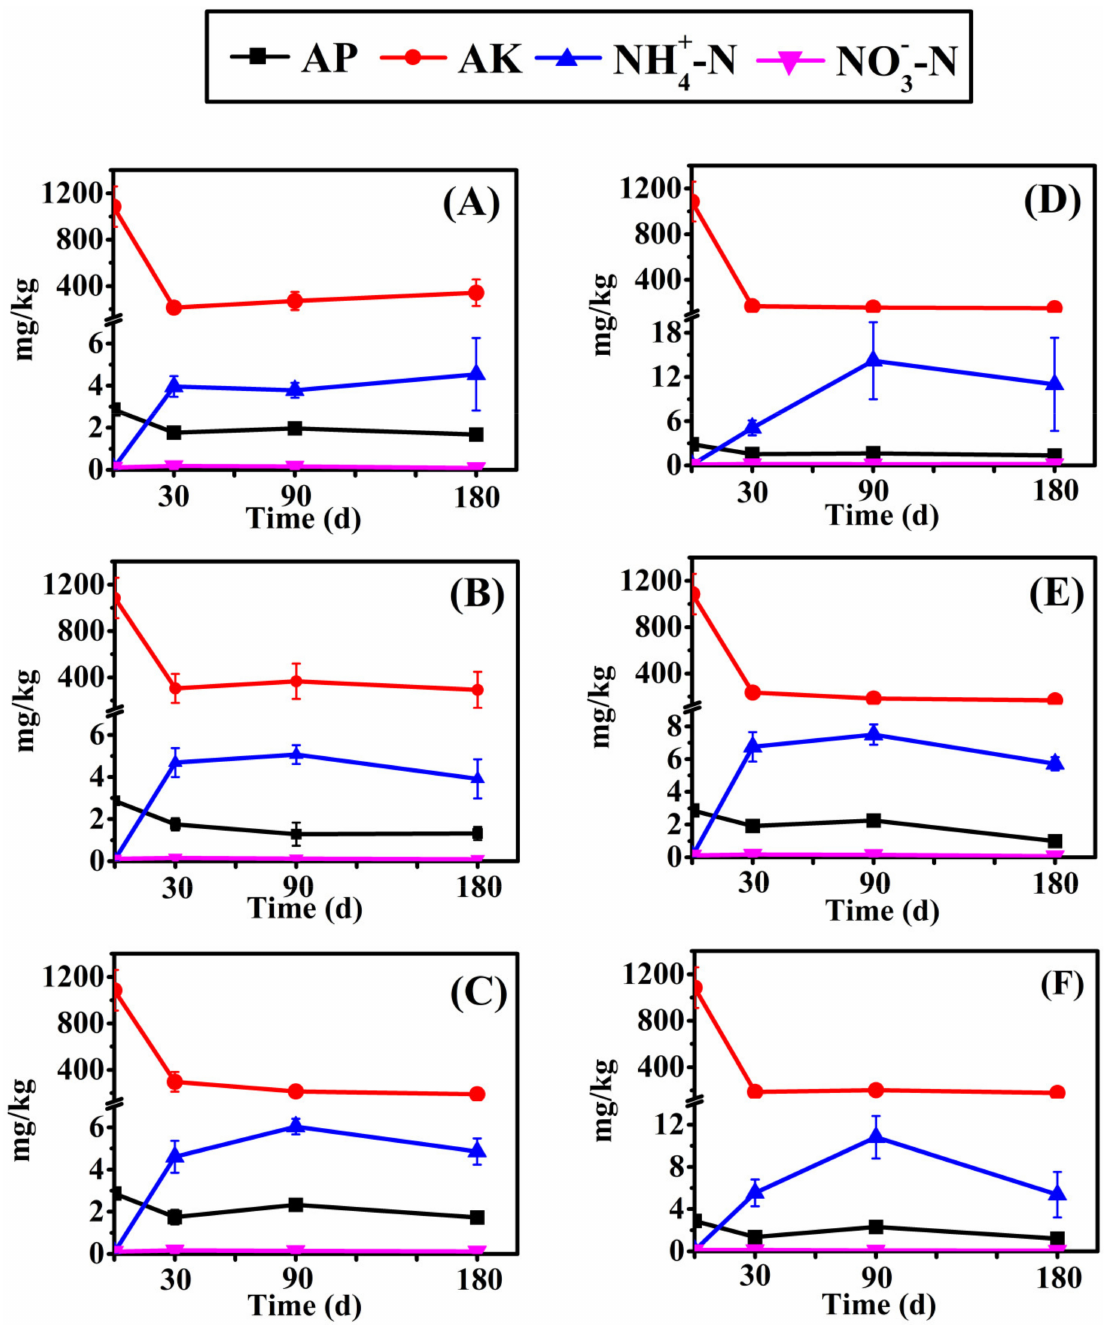
Figure 6. Soil available phosphorus, available potassium, ammonium nitrogen, and nitrate nitrogen concentration of E. crusgali and B. tripartita litter decomposition after 0, 30, 90, 180 days at 0, 5, 10 cm burial depths under flooding. ( A ) E. crusgali at 0 cm; ( B ) E. crusgali at 5 cm; ( C ) E. crusgali at 10 cm; ( D ) B. tripartita at 0 cm; ( E ) B. tripartita at 5 cm; ( F ) B. tripartita at 10 cm. Error bars indicate ± 1